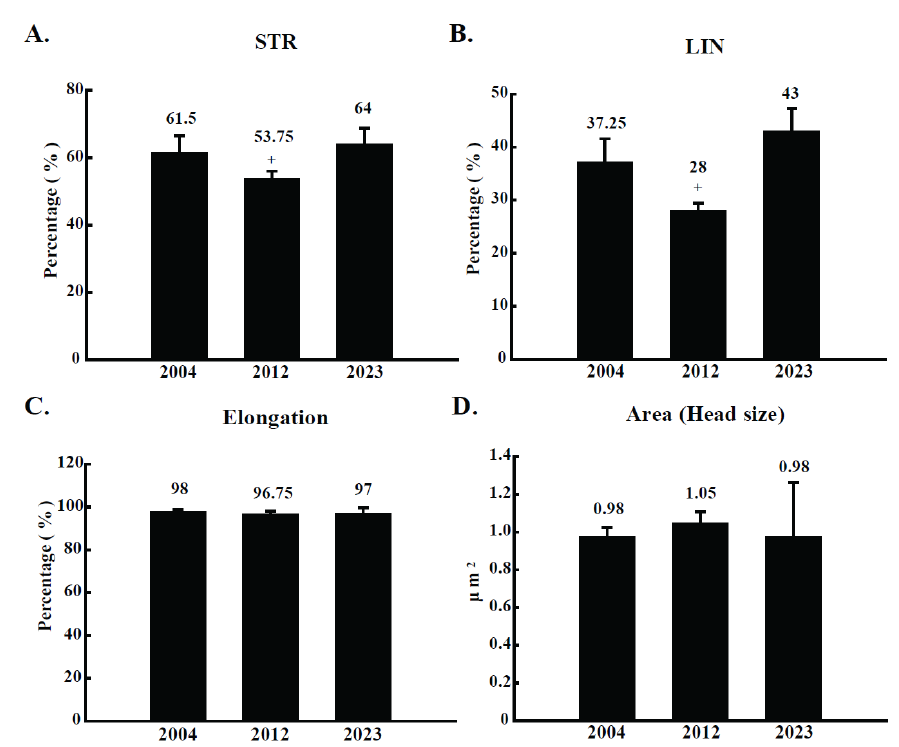
Figure 3. Comparison of motion and morphological index. Two motion indices were evaluated for boar 2004, 2012, and 2023. (A) straightness (STR, %) was calculated as the ratio of straight-line velocity (VSL) to average path velocity (VAP), and (B) linearity (LIN, %) was defined as the ratio of VSL to curvilinear velocity (VCL). Morphological abnormality was evaluated by measuring (C) sperm head elongation ratio (%) and (D) area (μm 2 ). Elongation was calculated by the ratio of minor to major axis of sperm head, and area corresponded to the head size. Semen was collected at five different times from the boars (n = 5). The collected semen was divided in triplicates and applied to CASA analysis. The results are expressed as mean±SD. p<0.05. CASA, computer assisted semen analysis; SD, standard